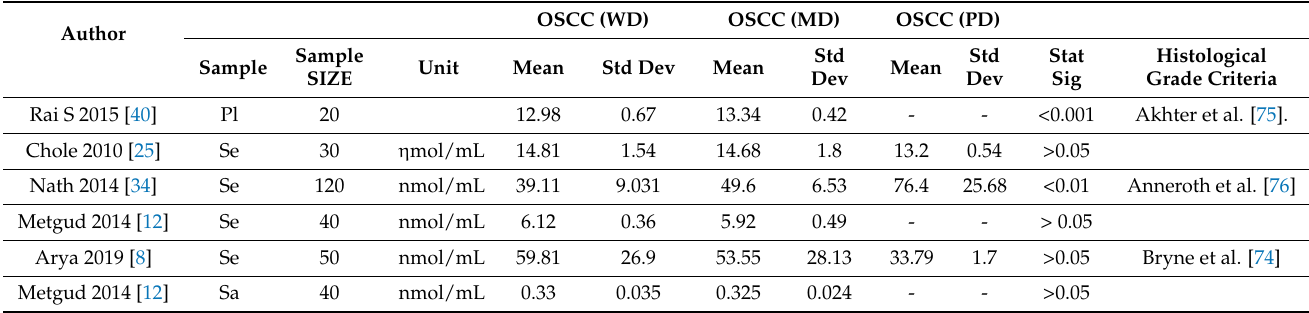
Table 4. The levels of MDA in various samples of patients with different histopathological grades of OSCC.